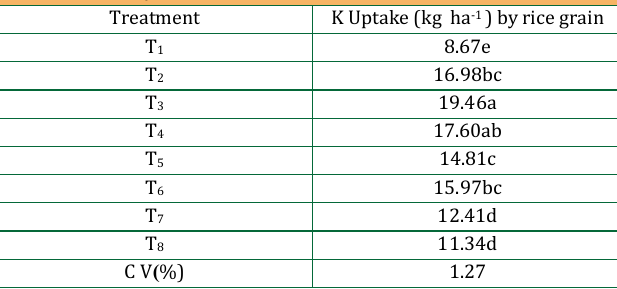
Table 4: Potassium uptake in rice grain of BRRI dhan49 as influenced by Banana leaves and chemical